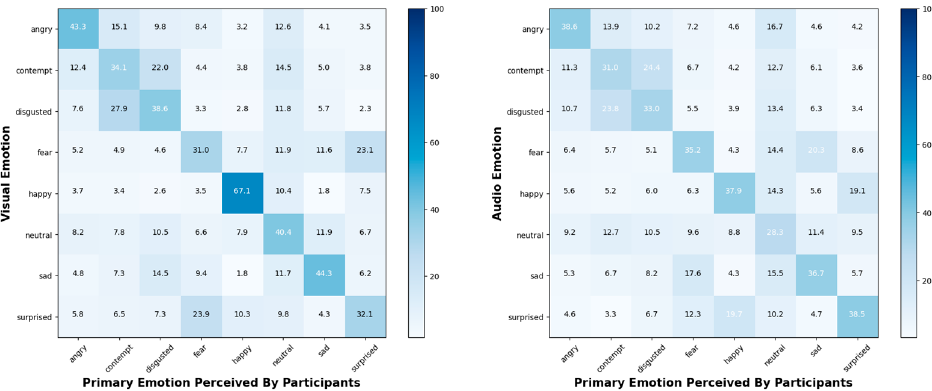
Figure 8. User survey of emotional perception of emotionally mismatched videos. Visual modality emotion perception ( left ) and auditory modality emotion perception ( right ).